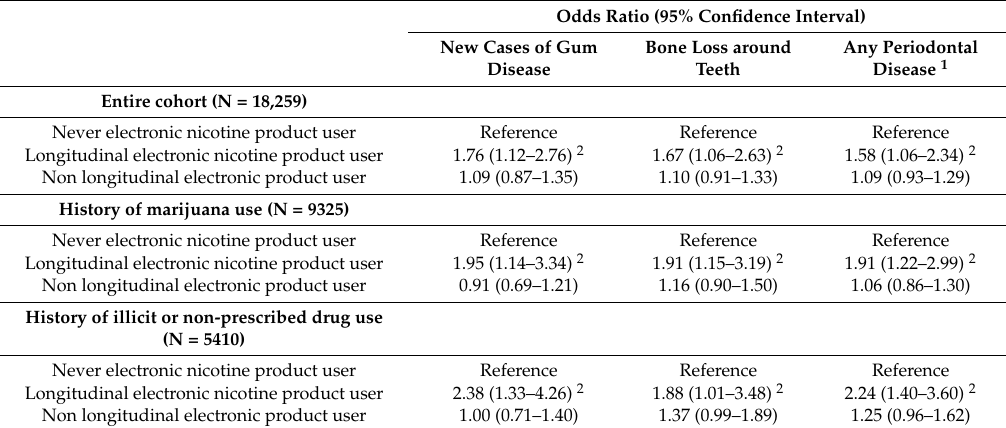
Table 2. Results of the Multivariable Logistic Regression